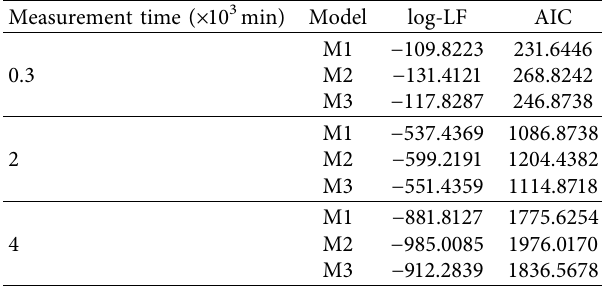
Table 4: AIC comparison between M1 model, M2 model, and M3